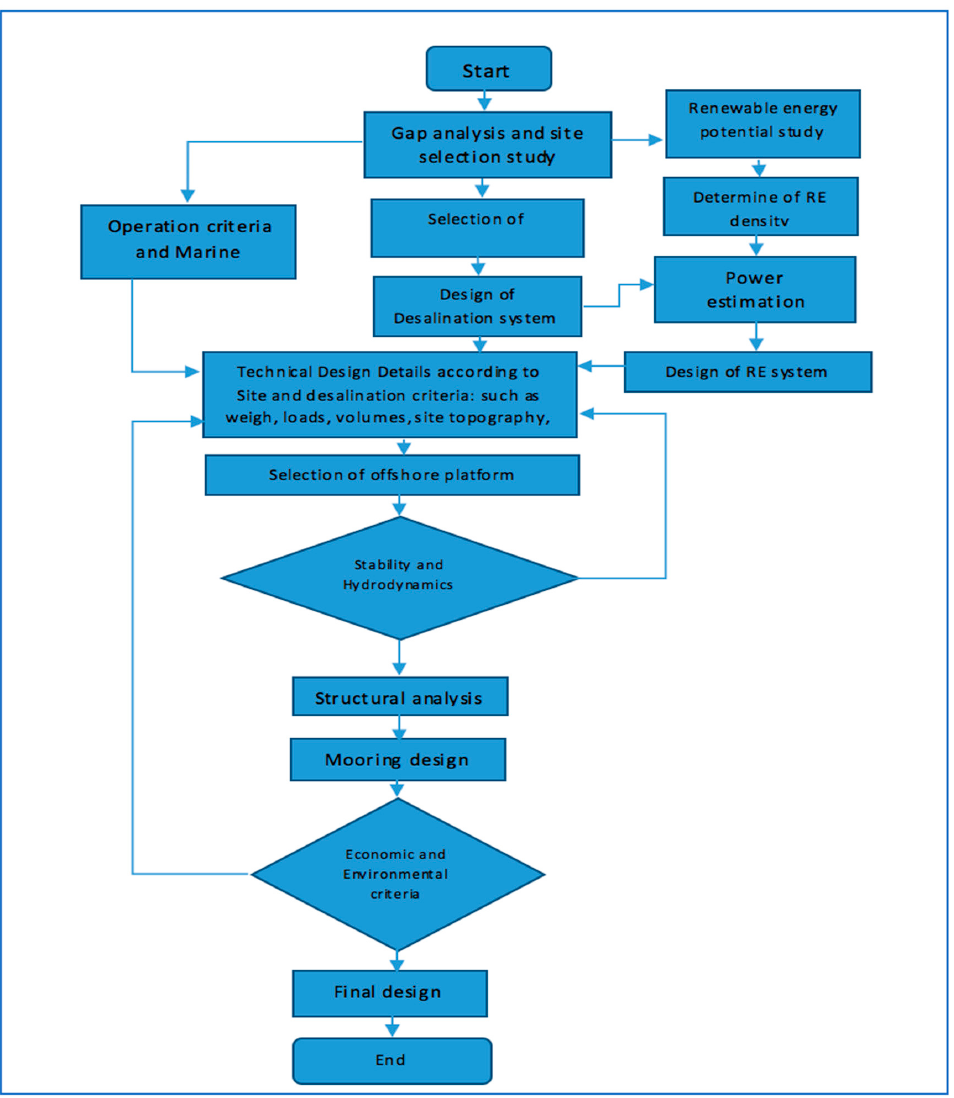
Figure 2. Design procedure for the FDP concept powered by marine renewable energy.